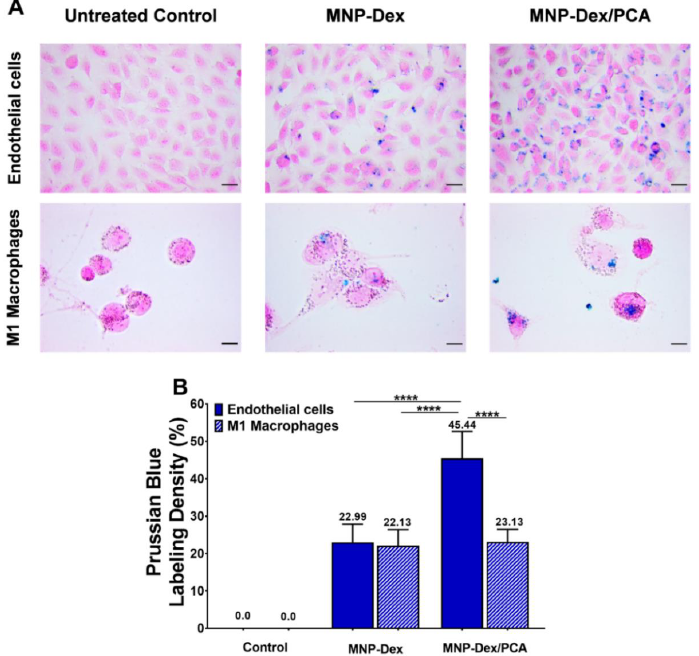
Figure 3. Bright-field microscopy images showing the uptake of magnetic nanoparticles at 62 μg/mL concentration in EA.hy926 cells (Endothelial cells) and THP-1 derived M1 macrophages after Prussian Blue staining ( A ) and the quantification of iron-labelled cells using ImageJ software ( B ). The data are expressed as mean ± SD from two independent experiments. **** p < 0.0001. Scale Bar: 10 μM.